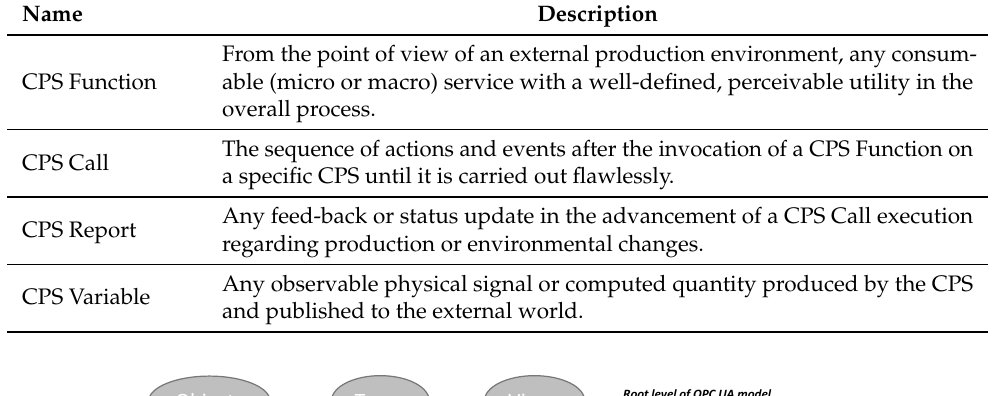
Table 4. List of CPS service concepts.